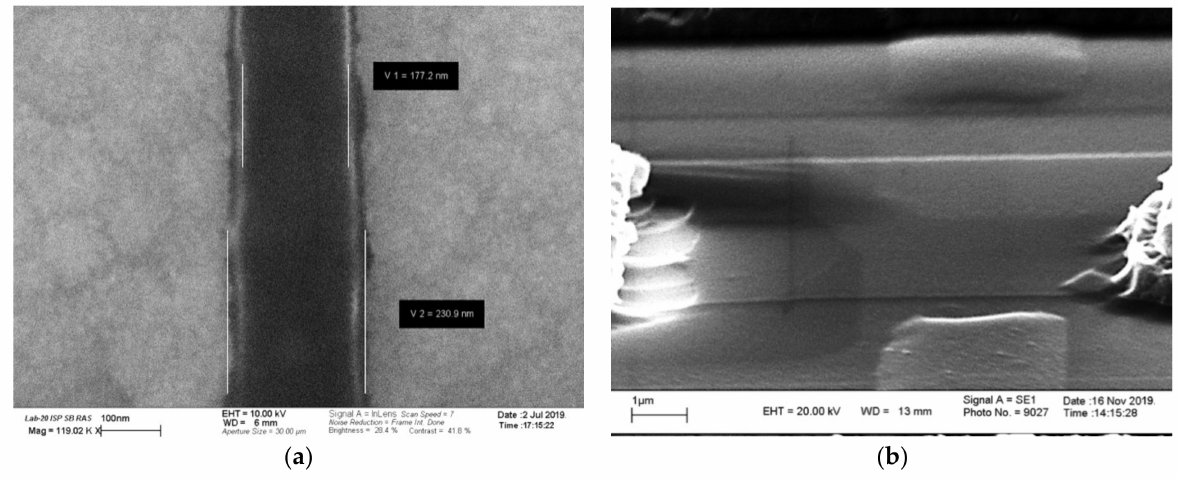
Figure 2. Typical scanning electron microscopy (SEM) images of NRs with a width of 200 nm (( a ), top view) and 3 µ m (( b ), at a 60 ◦ angle to the surface).